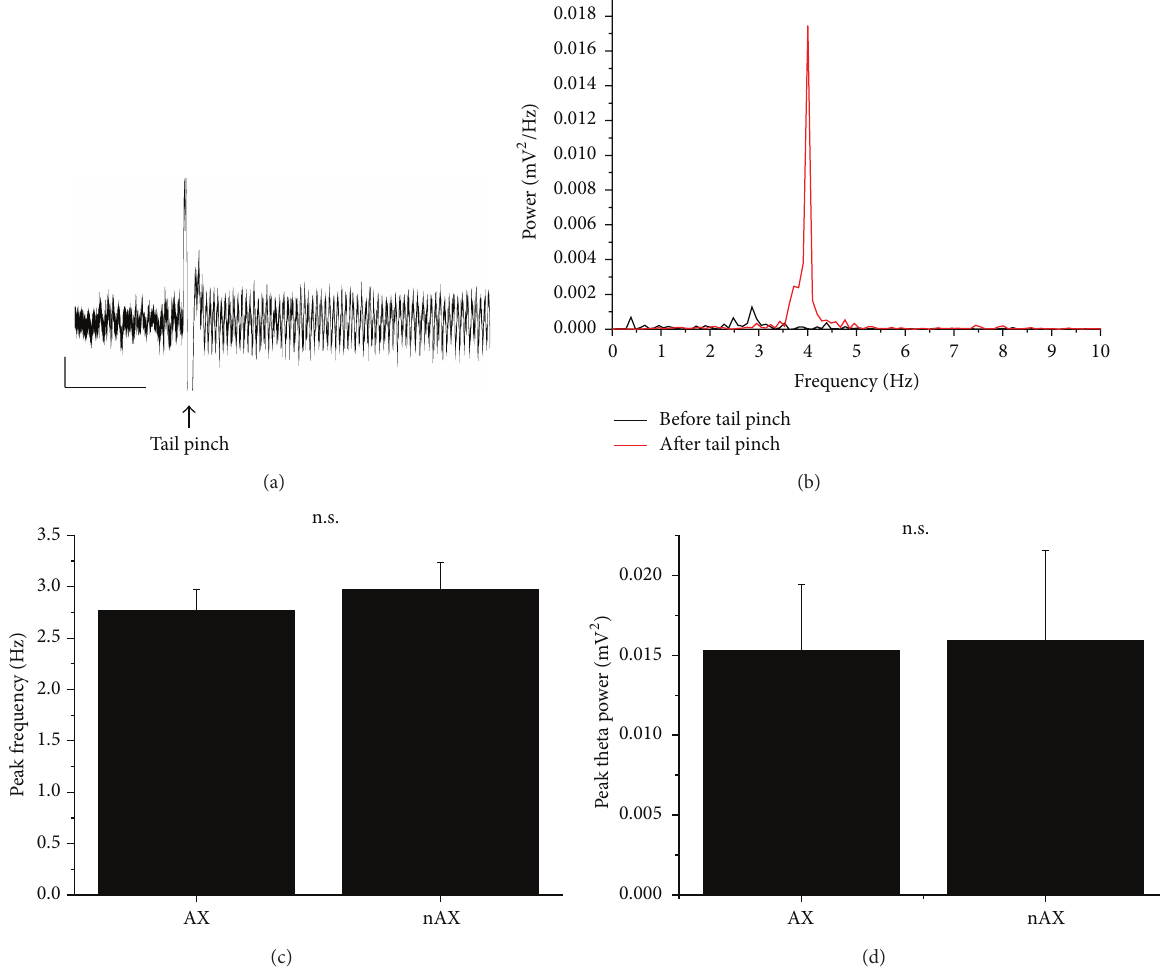
Figure 3: A brief tail pinch evoked a prominent oscillation (a), which was in the theta range (b). There was no difference in the peak frequency (c) and in the peak theta power (d) between AX and nAX mice. Calibration bars are 10 sec. and 0.5